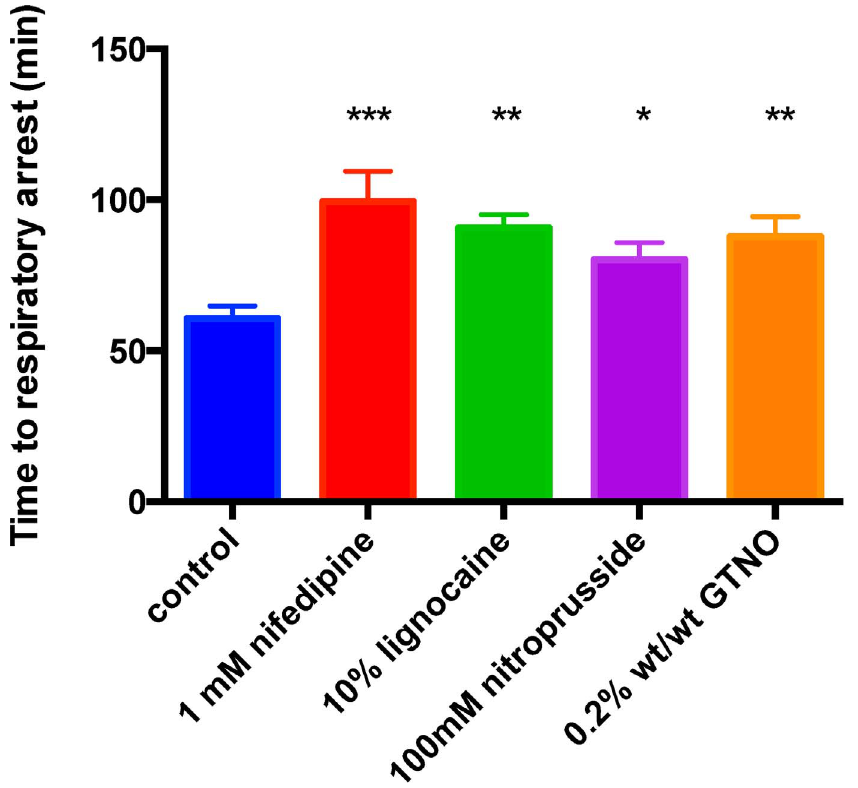
Figure 5. Summary bar plots of the mean times to respiratory arrest under control and test conditions for several pharmacological agents applied topically at the concentrations noted following injection of brown snake venom at the equivalent of 1 mg/kg. All agents caused significant increase in time to respiratory arrest compared to control. Asterisks indicate significant differences with respect to control obtained by Mann Whitney test (* p , 0.05, ** P , 0.01, *** p , 0.001; n=11, 8, 5, 5 & 7 for control, nifedipine, lignocaine, 100 mM sodium nitroprusside and 0.2% wt/wt glyceryl trinitrate ointment respectively).